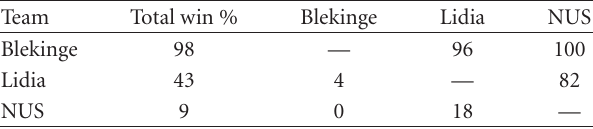
Table 7: Results from the ORTS Tankbattle 2008